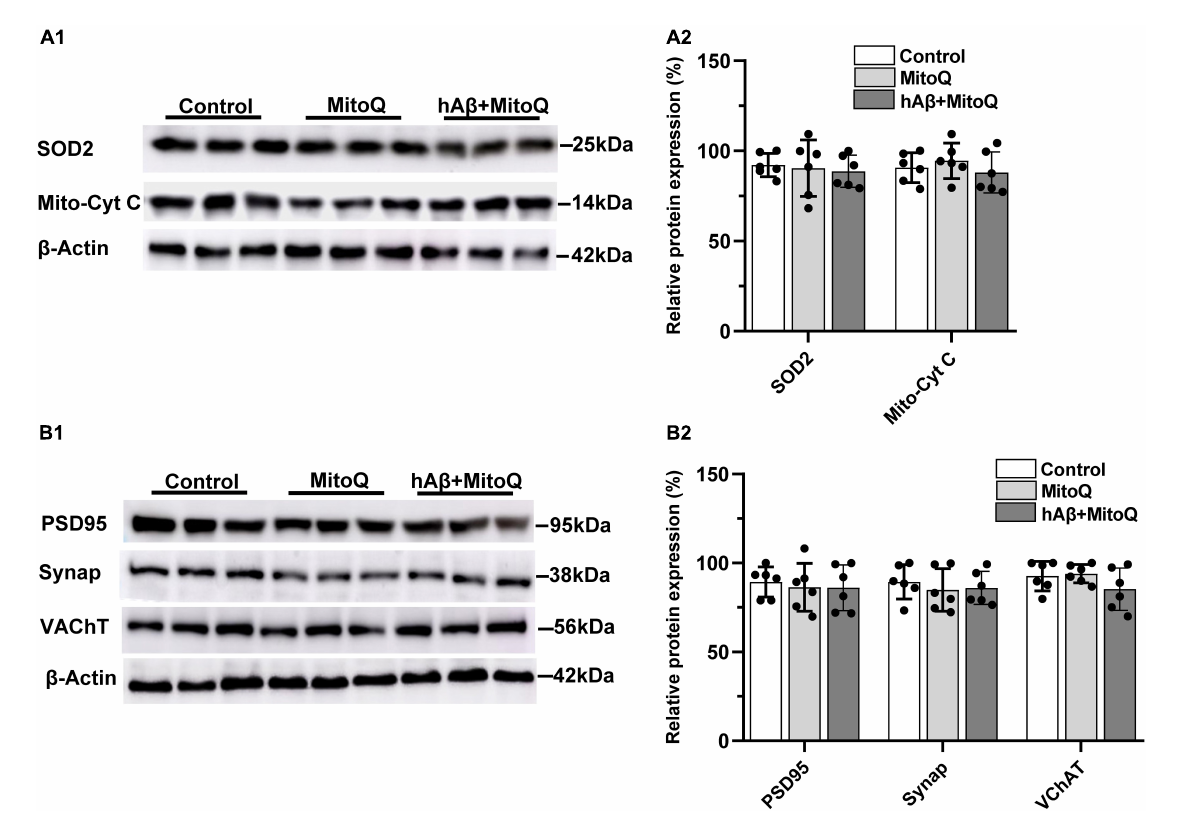
FIGURE3 Inhibiting increases in reactive oxygen species with MitoQ prevents hA β 1 − 42 -induced changes in mitochondrial and synaptic proteins. (A1) Representative immunoblots of superoxide dismutase 2 (SOD2), mitochondrial cytochrome c (Mito-cyt C), and the loading control β -Actin, are shown in slices treated with MitoQ, hA β 1 − 42 with MitoQ, and control. (A2) Normalized relative expression of SOD2 and Mito-cyt C proteins ( n = 6). (B1) Representative immunoblots of postsynaptic density protein PSD95, presynaptic marker synaptophysin (Synap.), vesicular acetylcholine transporter (VAChT), and the loading control β -Actin are shown in tissue treated with MitoQ, hA β 1 − 42 with MitoQ, and control. Bar graphs indicate normalized relative expression of PSD95, Synap., and VAChT (B2) .